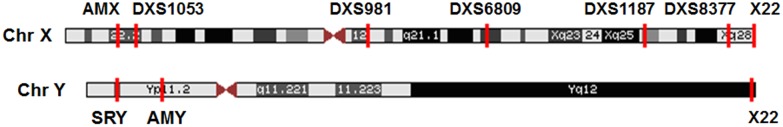
Graphic scheme of the chromosomal localization of the eight sex chromosomal markers used in the newly designed multiplex PCR assay.The markers were located according to Human Genome Browser – hg38 assembly.